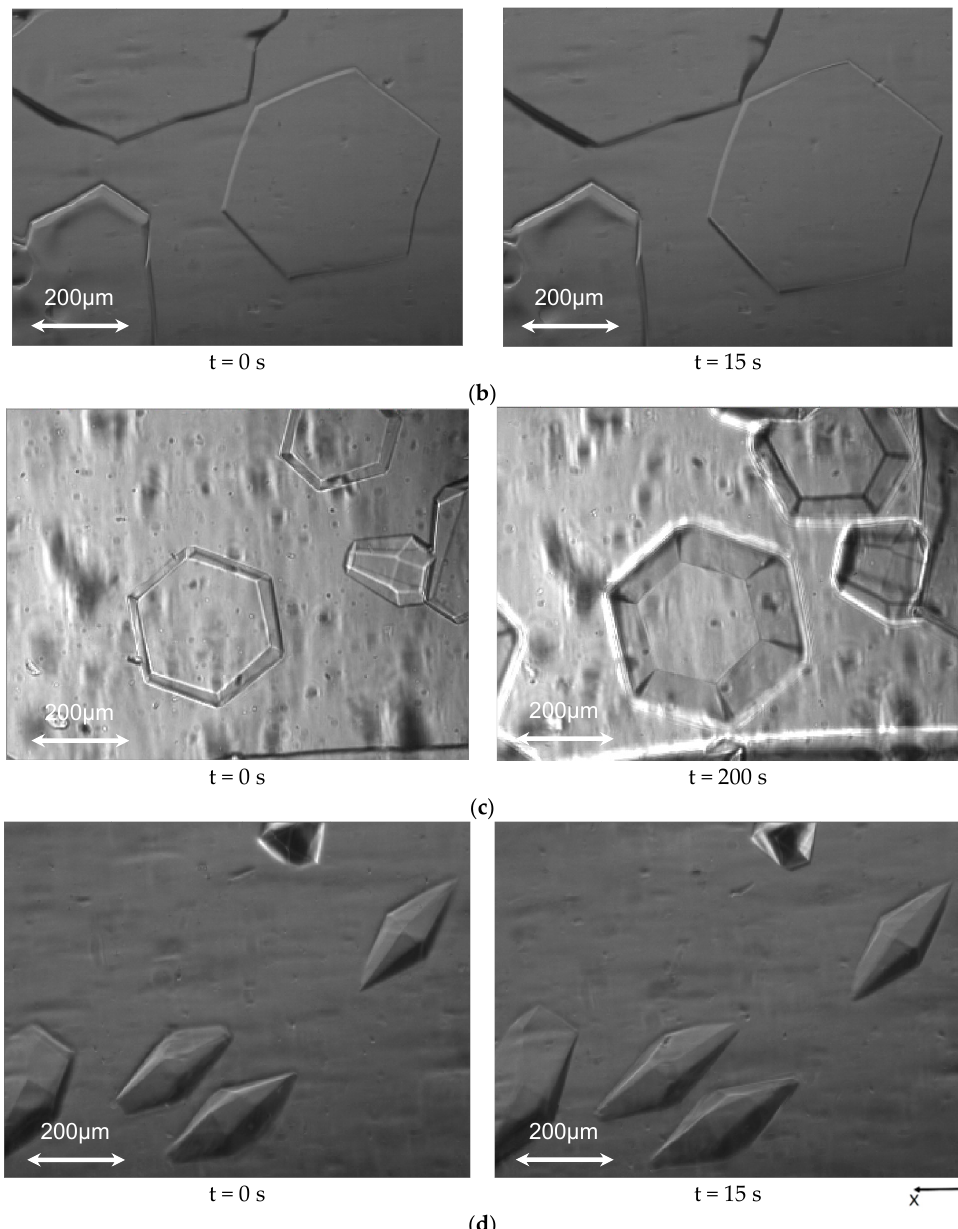
Figure 3. Shapes of typical ice particles in the quiescent ice slurry. ( a ) In the case of c = 0 mg/mL; ( b ) In the case of c = 0.125 mg/mL; ( c ) In the case of c = 0.25 mg/mL; ( d ) In the case of c = 0.50 mg/mL. In the case of quiescent ice slurry with HPLC6 whose concentration was 0.125 mg/mL, the ice particles became plates with the shape of a hexagon when the image-capturing started (see Figure 3b). These plates grew in the normal direction to the edge surfaces of the hexagonal shape, i.e., in the a -axis direction.